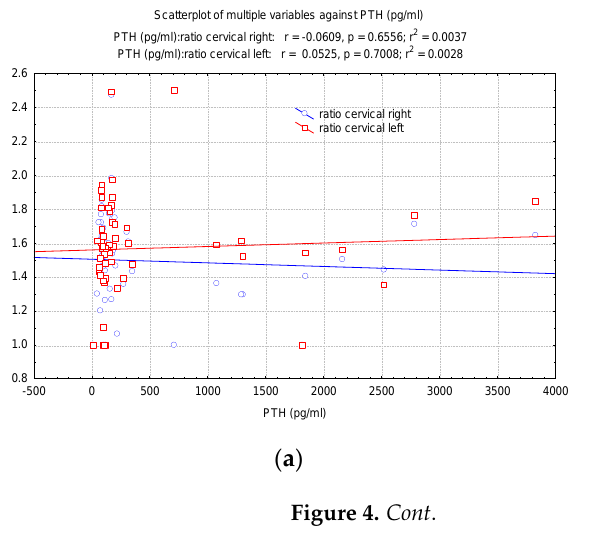
Figure 3. Pearson correlations between the demographic aspects ( a , b ) age, ( c , d ) body weight, ( e,f ) BMI and the values of (total counts/pixels) BAT /(total counts/pixels) non-BAT ratio.